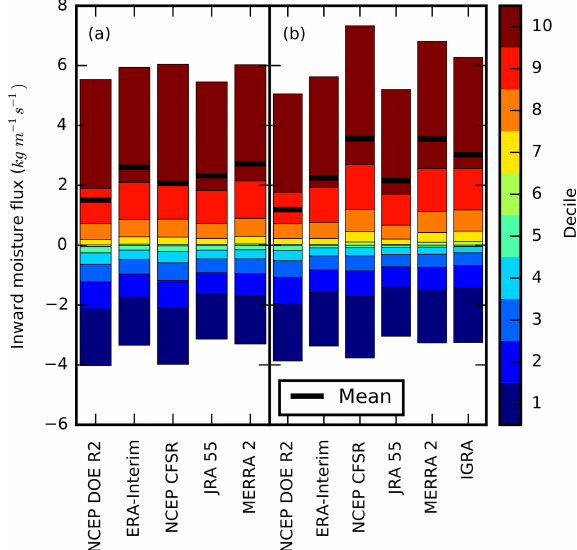
Figure 8. Breakdown of the climatological vertically integrated moisture flux into the contribution of its different deciles. When a decile is represented below the origin, its contribution is negative. The top of the bar indicates the mean transport when negative val- ues are set to zero. The difference between the top and bottom is the mean transport, symbolized by the bold black line. In panel (a) , the flux deciles are averaged over the East Antarctic boundary, whereas in panel (b) the deciles are computed by aggregating the data over stations only with the same temporal sampling as